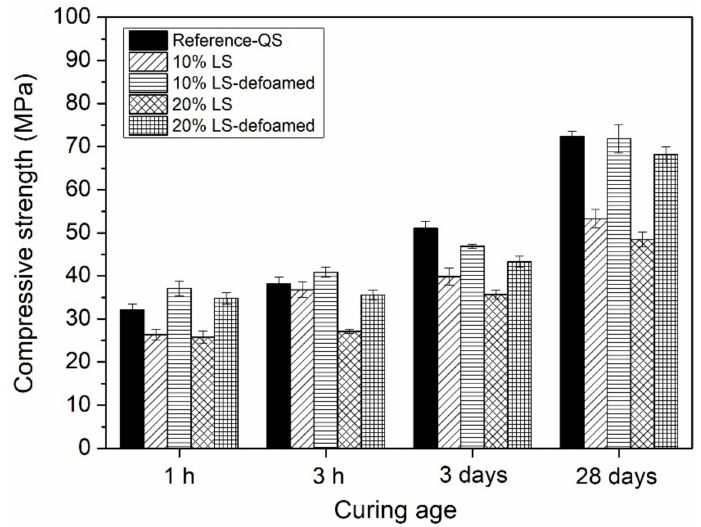
Figure 8. Compressive strength (at curing age of 1 h, 3 h, 3 days, 28 days) of MAPC mortar samples containing limestone fines (at content of 10% and 20%) with or without defoaming treatment by the compound use of 0.3% polyether modified silicone (PMS) defoamer and 1% Portland cement (PC).